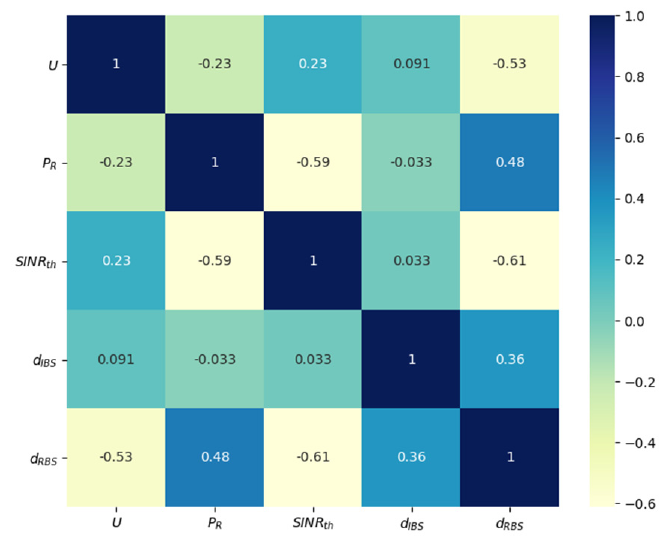
Figure 4. Pearson correlation of all variables.